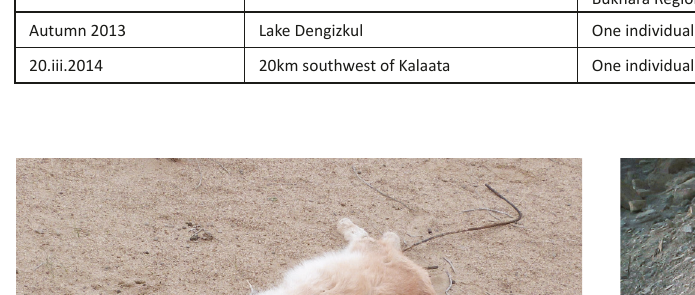
Several sightings of individuals. One individual sighted. Caracal footprints found by M. Gritsina. Three individuals killed by herders. One individual sighted by F. Salimov, an official of the Bukhara Regional Committee for Nature Protection. One individual sighted by F. Salimov. One individual killed by